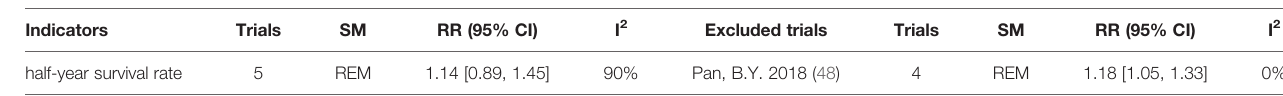
TABLE 4 | Sensitivity analysis.